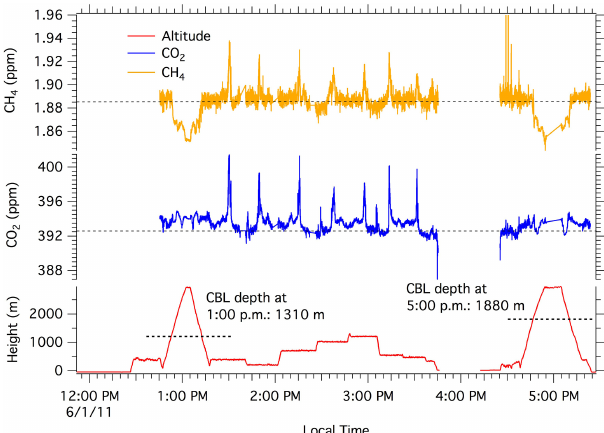
Figure 3. Temporal distribution of altitude (ma.g.l.), carbon diox- ide, and methane on 1 June 2011. The broken lines in the CO 2 and CH 4 time series represent the mean background concentration averaged over all altitudes (392.6 ± 0.5ppm and 1880.6 ± 2.6ppb for CO 2 and CH 4 , respectively). Two vertical profiles were per- formed during this flight experiment, showing a ∼ 570m growth in the boundary layer depth from the beginning of the